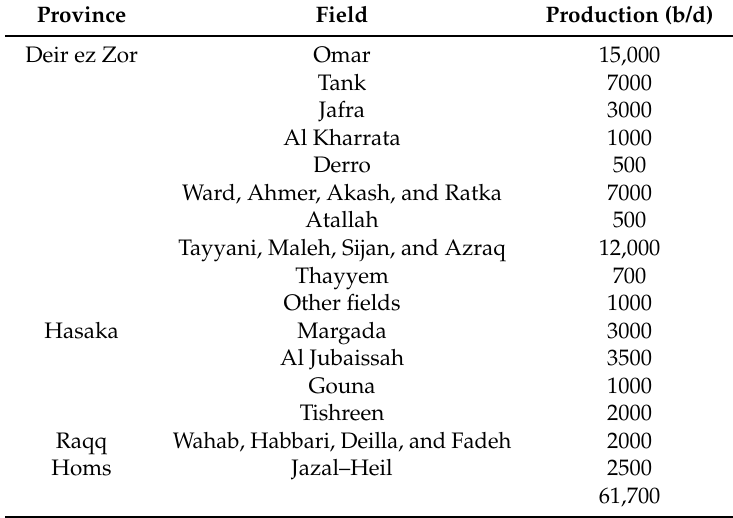
Table 1. Oil production (b/d) under control of IS in summer 2015